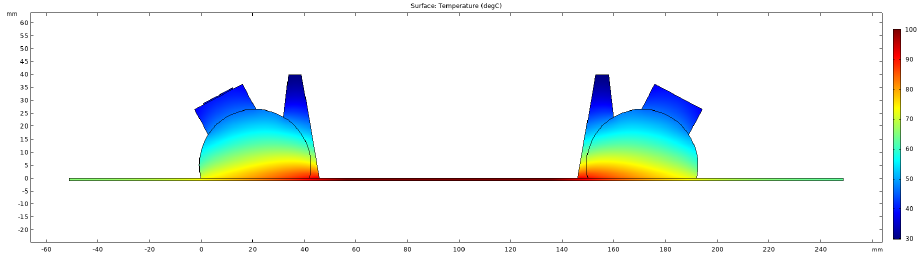
Figure 3. Simulated temperature gradients from stationary study at 100